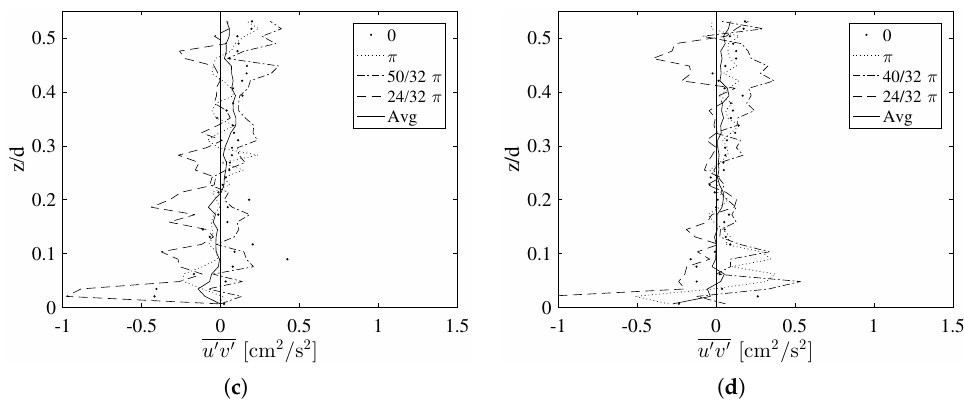
Figure 10. T 9 test ( H = 5.86 m, T = 1.26 s), turbulence phase analysis: ( a ) tke profile at P 2 , L 2 ; ( b ) tke profile at P 2 , L 8 ; ( c ) Reynolds stress profile at P 2 , L 2 ; and ( d ) Reynolds stress profile at P 2 , L 8